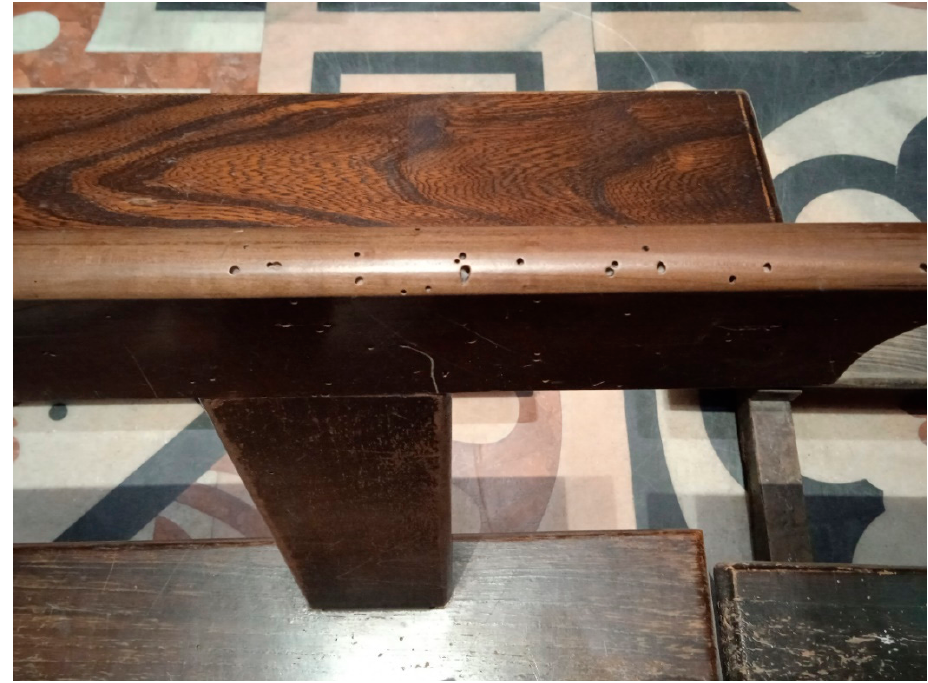
Figure 14. View of a wooden bench attacked by woodworm.